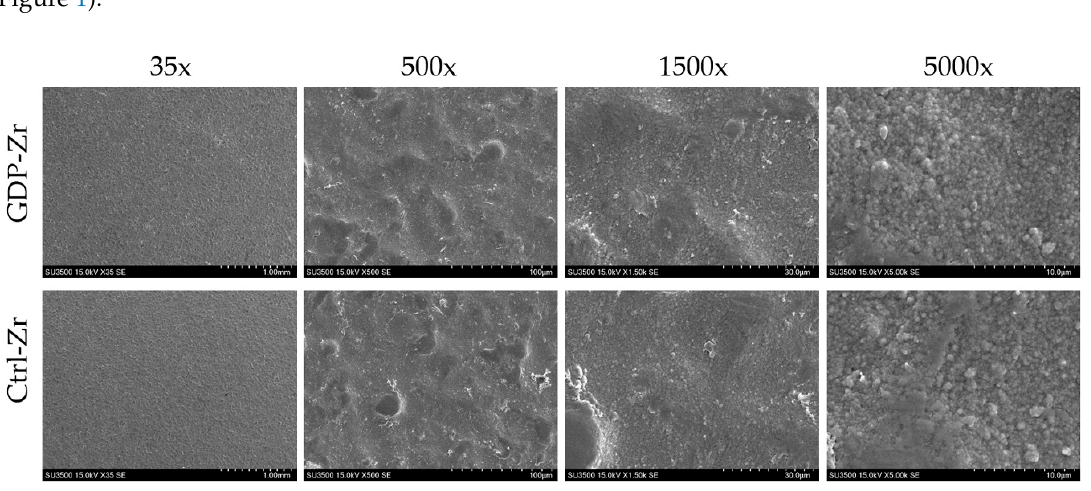
Figure 1. Observation of the Zr discs’ surfaces using SEM.